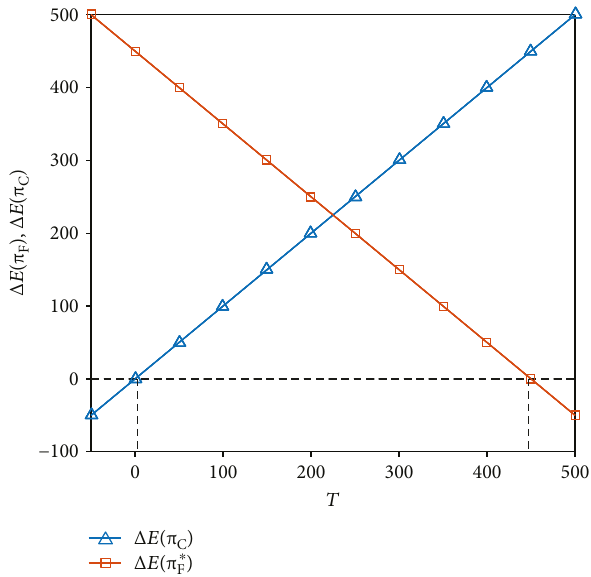
Figure 12: E ff ect of T on supply chain